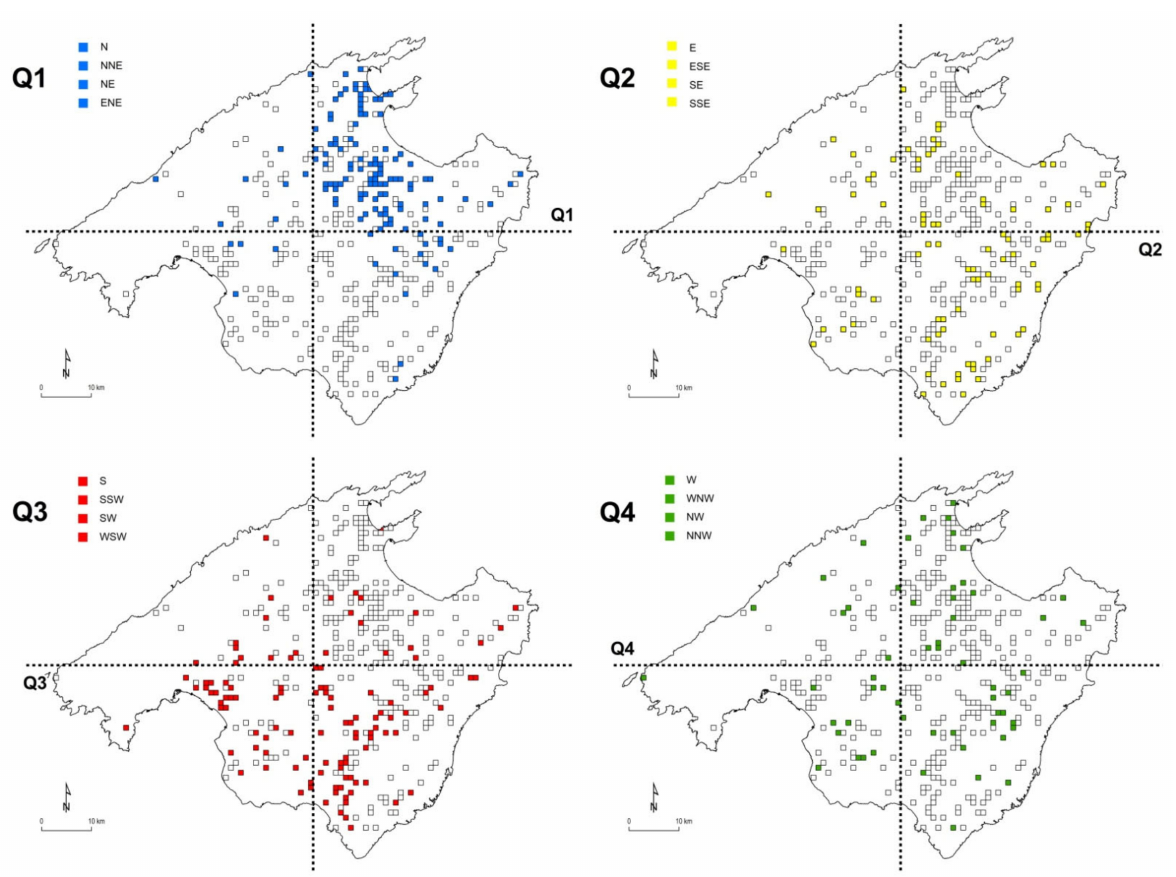
Figure 12. ‘Anemographic’ sea-breeze directions (colored pixels) recorded for each threshing floor, separated into the usual four wind quadrants ( Q ).